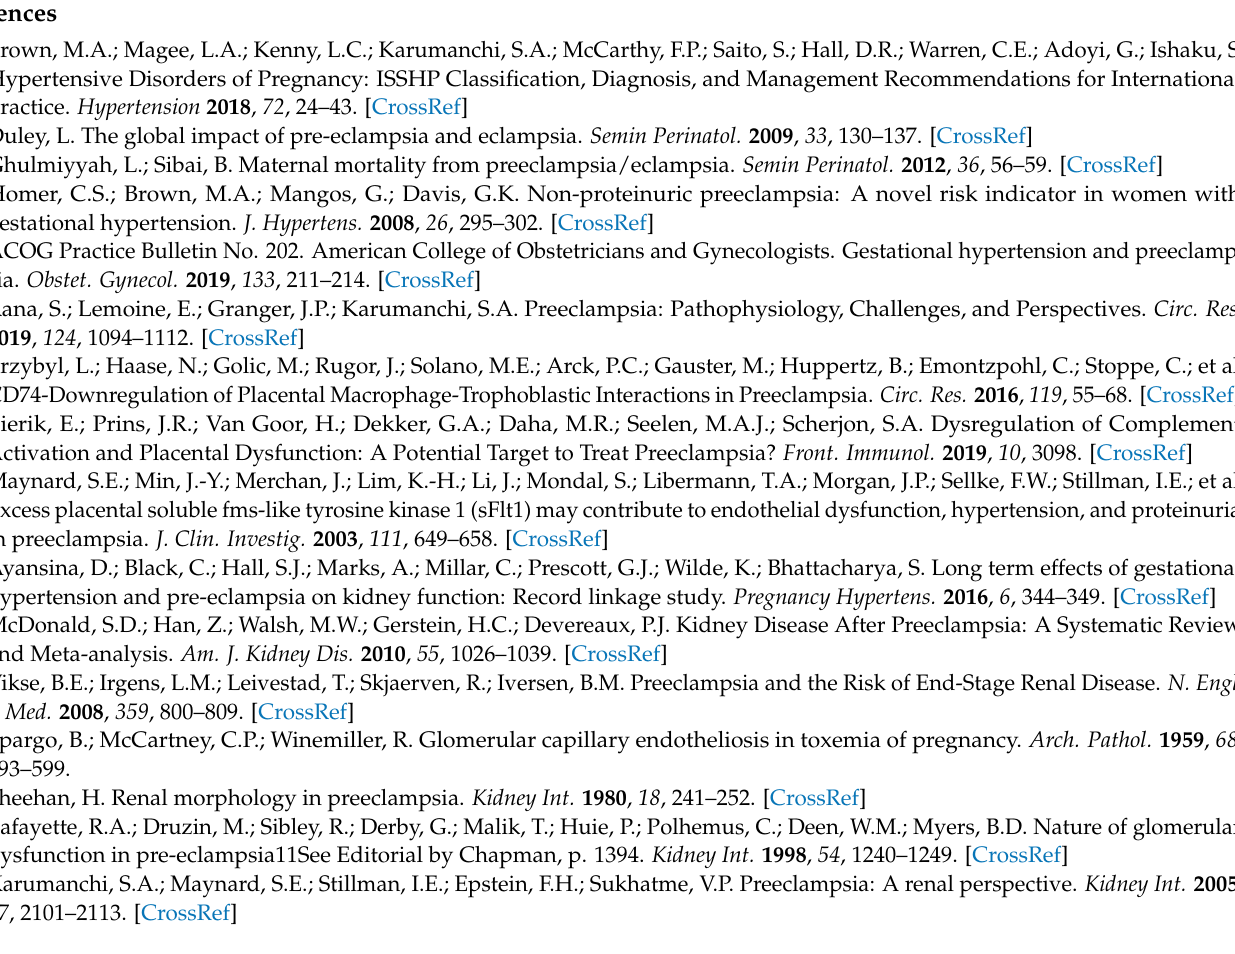
tum. Table S1: Primer pairs and probes used for RT-qPCR, Table S2: Relative gene expression of marker